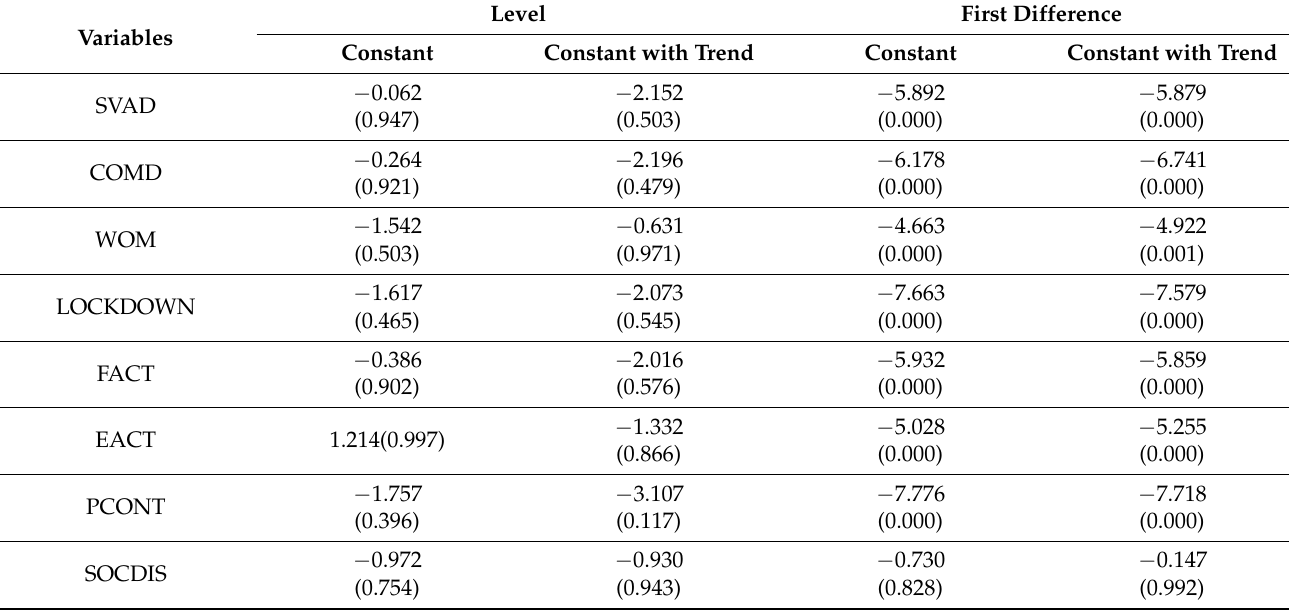
Table 4. Unit Root